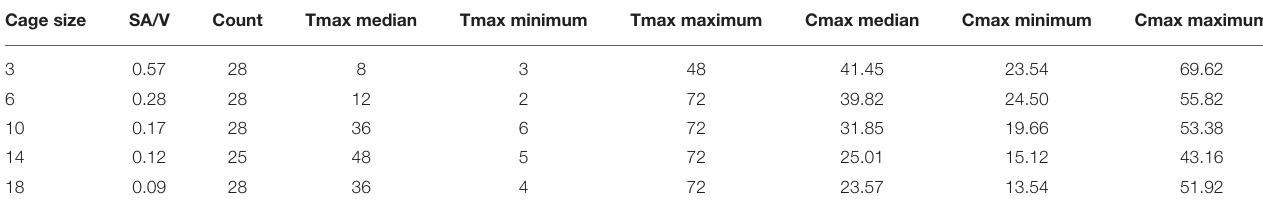
TABLE 4 | Median and range of observed time to maximum concentration (Tmax) in hours and the concentration of carprofen (Cmax) achieved in micrograms per millilitre for each tissue cage size implanted. Cage size